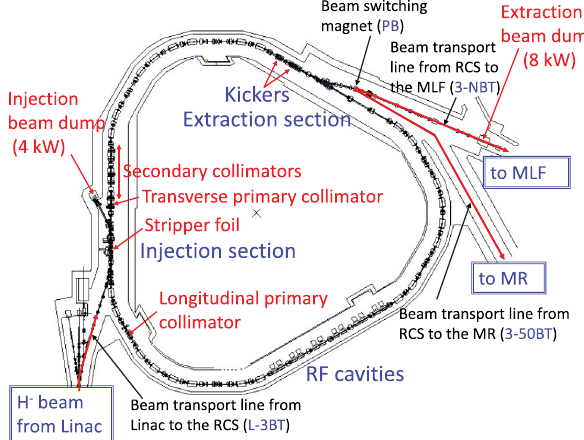
beam.FIG. 1. Schematic view of the 3-GeV RCS of J-PARC. Extracted beam is delivered to both the MLF and MR with time sharing at a repetition rate of 25 Hz. A pattern dipole magnet named pulse bending magnet (PB) located downstream of the RCS extraction line acts as a switching magnet for changing beam destination MLF to MR according to the opera- tion